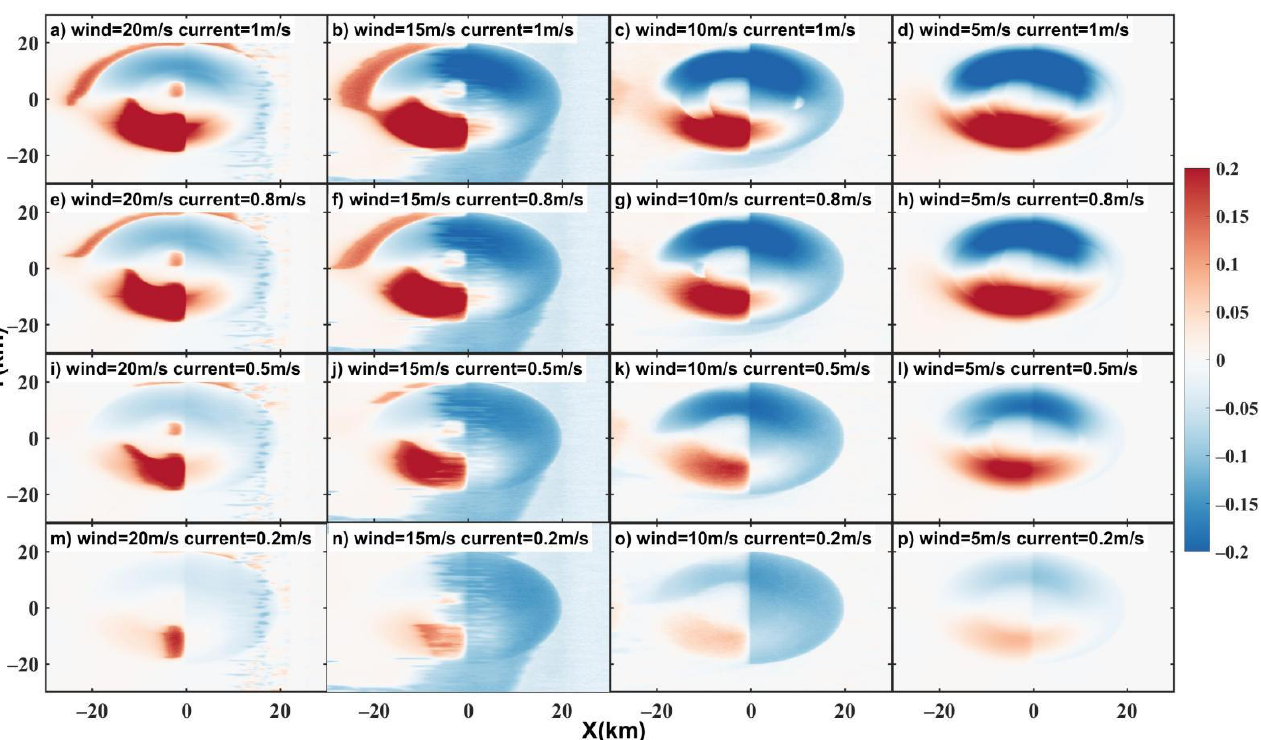
Figure 5. Same as Figure 3, but for wave steepness.